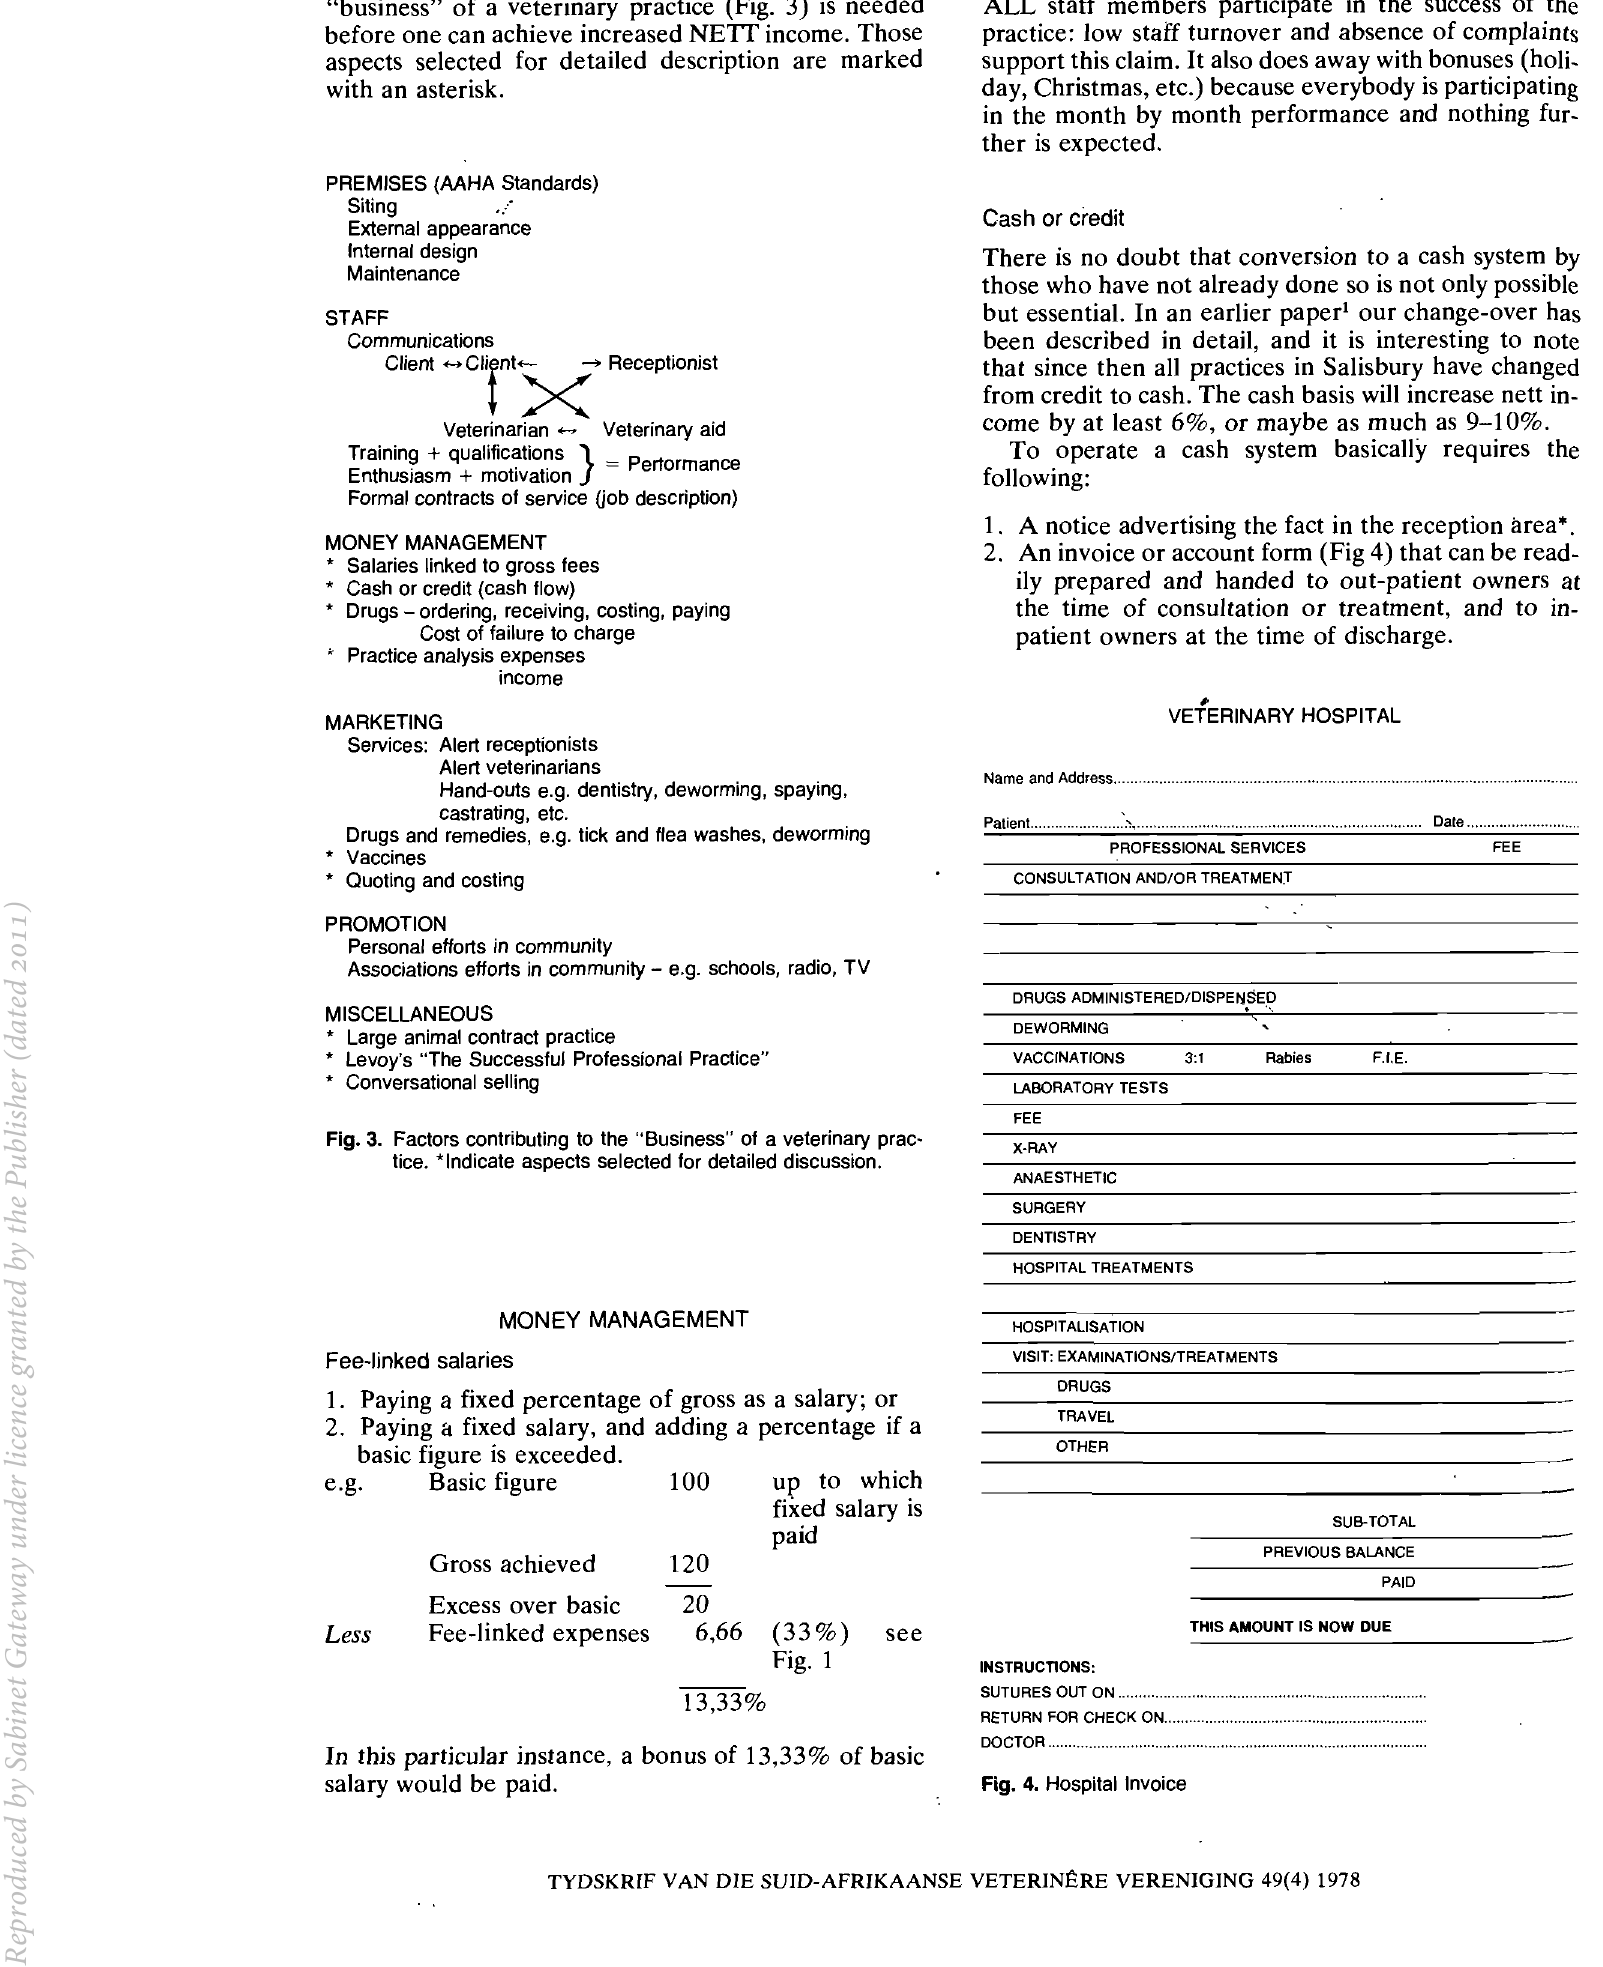
Fig. 3. Factors contributing to the "Business" of a veterinary prac tice. 'Indicate aspects selected for detailed discussion.